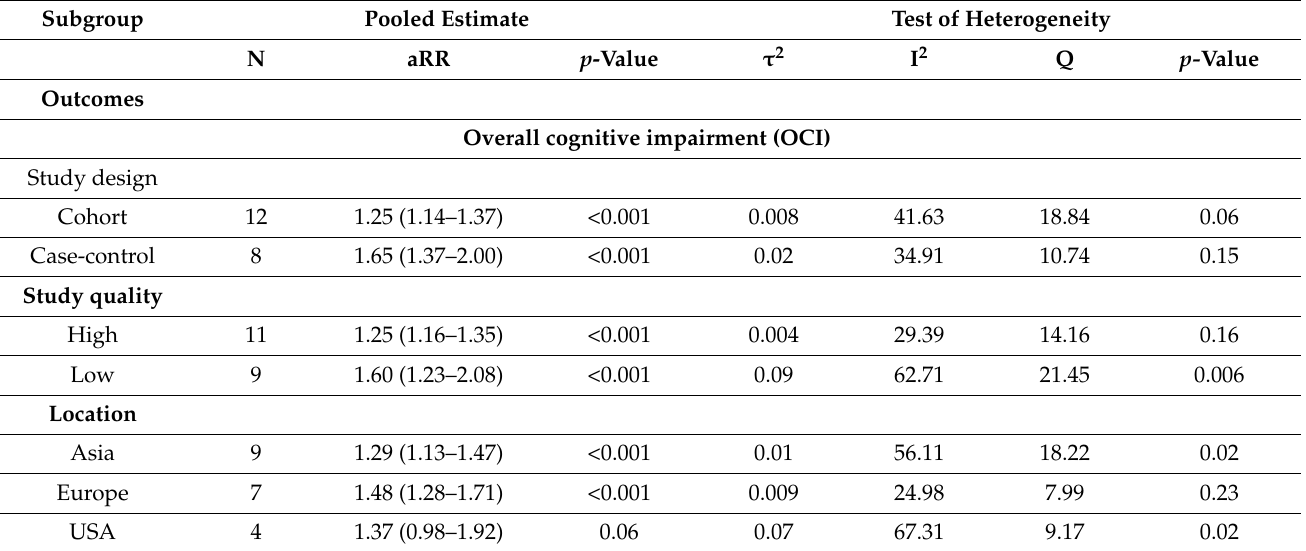
Table 2. Subgroup Table 2. Subgroup Analyses.